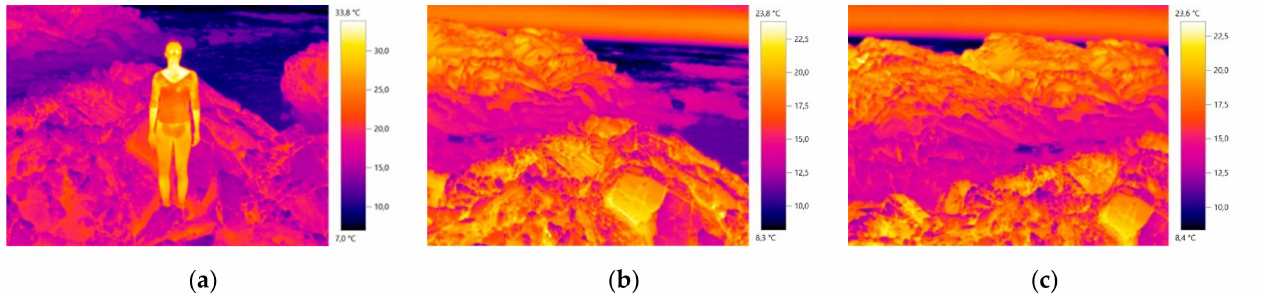
Figure 2. Thermal images of the base of the conceptual process of the nocturnal prototype: ( a ) with the presence of the human body; ( b ) and ( c ) with the absence of the human body.